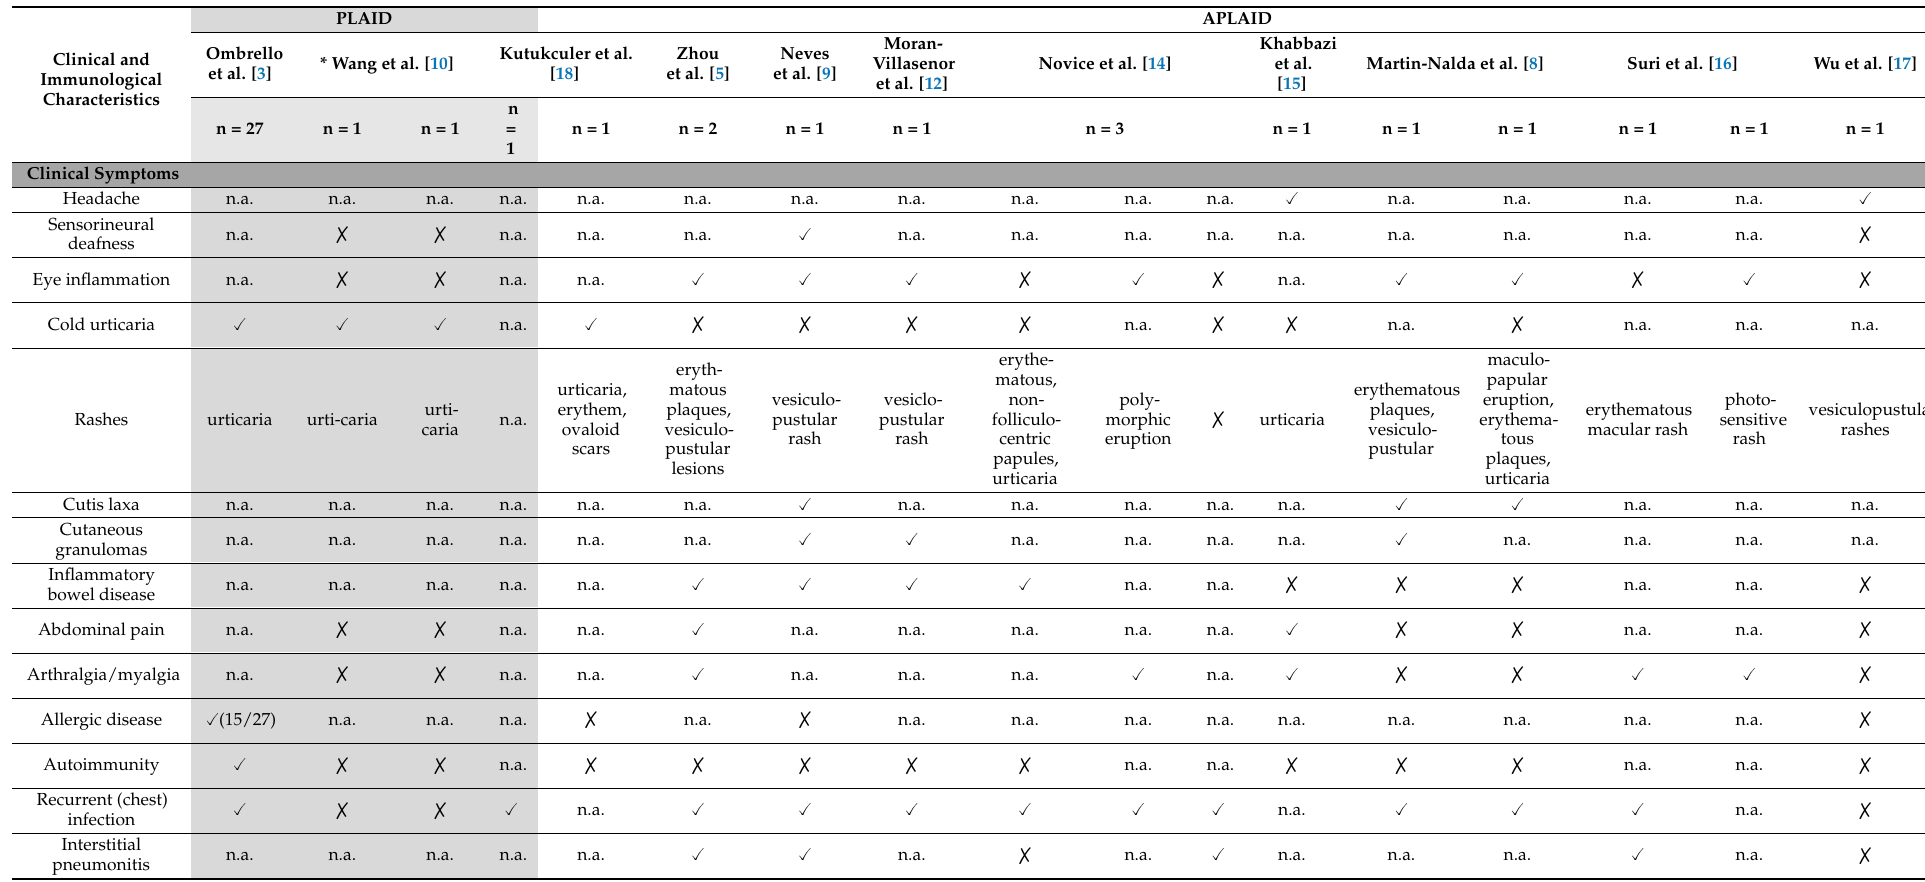
Table 1. Clinical and laboratory characteristics of patients with the heterozygous missense PLCG2 variant (c.77C>T, p.Thr26Met).